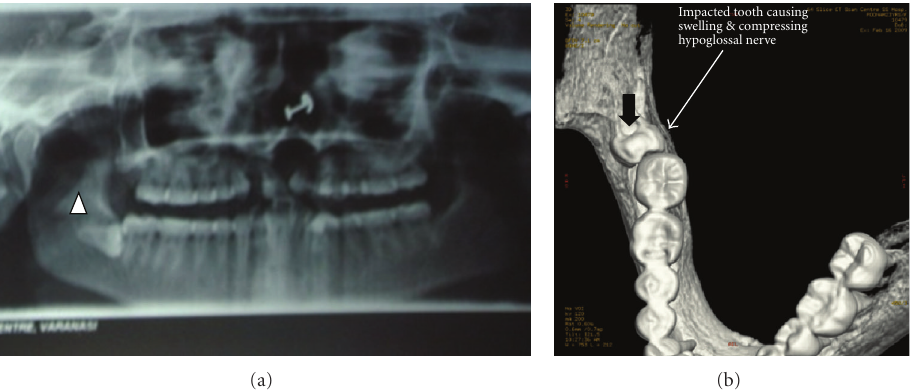
Figure 2: (a) Oral Pantogram showing the impacted third molar on the right lower jaw (arrow head). (b) The denta scan of the lower jaw showing the horizontal lying impacted third molar (arrow).